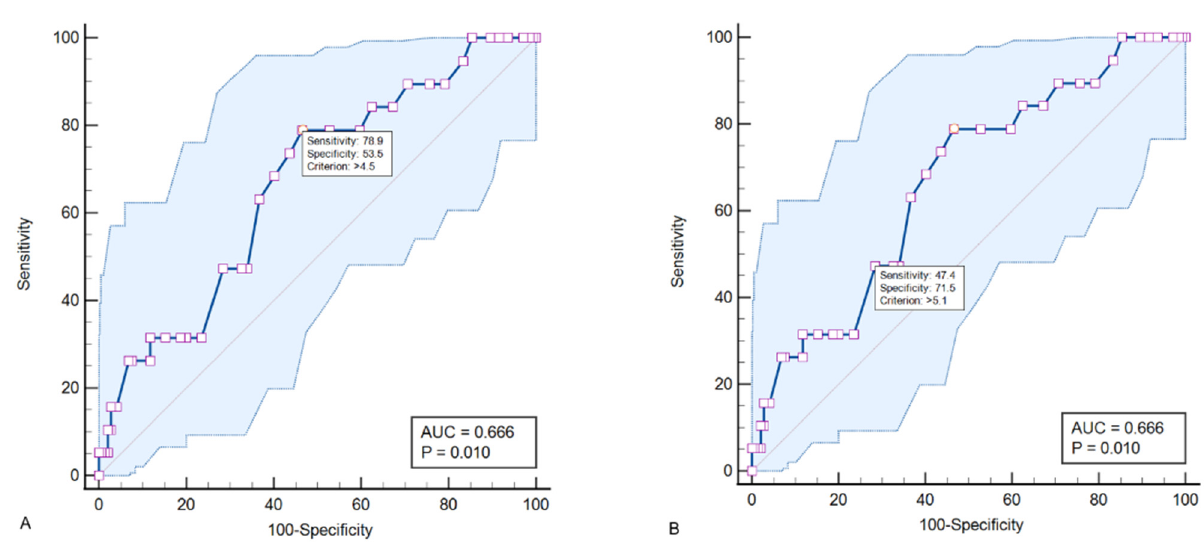
Figure 4. Liver stiffness values in patients with generalized atherosclerosis (ABS = 4). Each point represents a single case. The lines in the figure represent (from inside to outside): median, upper and lower quartile, minimum and maximum.